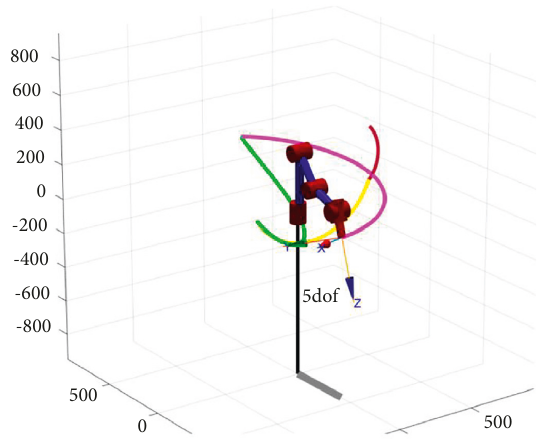
Figure 10: Trajectory of the robot.